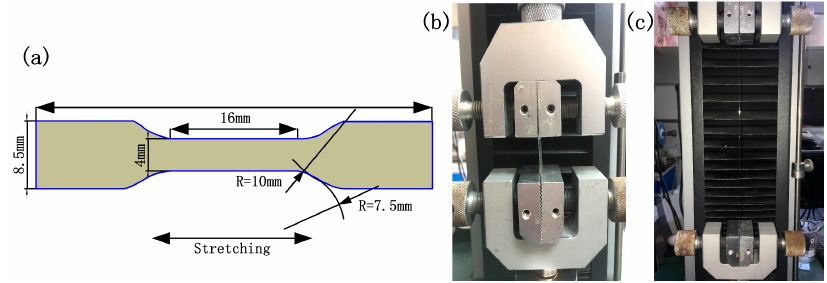
Figure 1. Dimensions of the test sample ( a ) and the stretching setup ( b , c ).